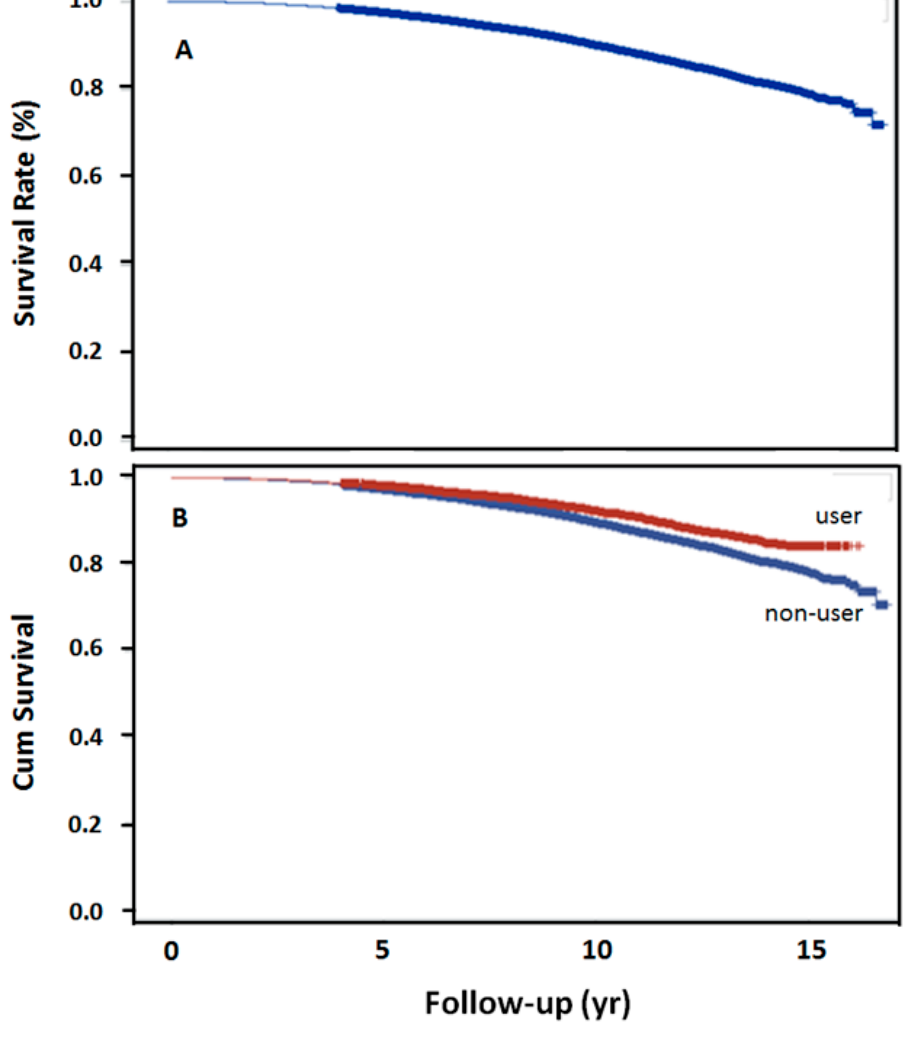
Figure 2. 15-year overall survival rates in 2 groups. ( A ) Overall survival rate following schizophrenia and subsequent dyslipidemia ( n = 18,244), ( B ) overall survival rate with the use of simvastatin following schizophrenia and dyslipidemia ( p < 0.0001).